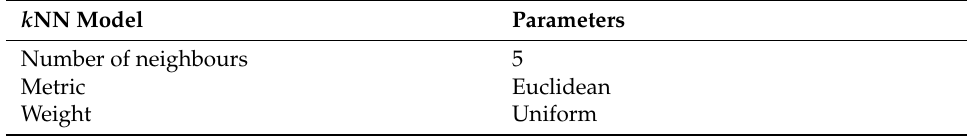
Table 4. The parameters of k NN